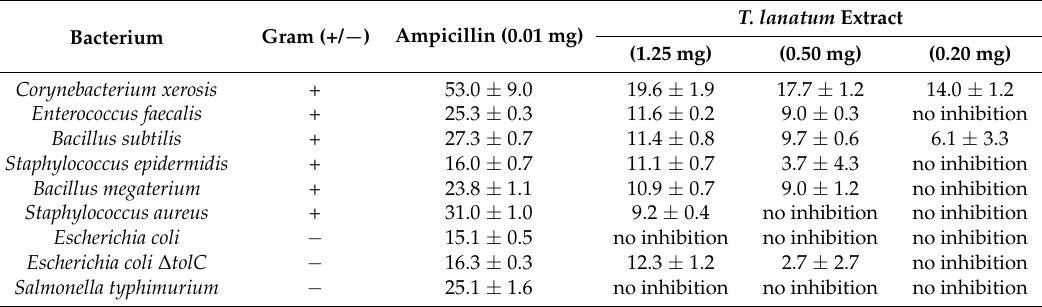
Figure 2. Immunomodulatory activity of T. lanatum extract. The amount of the pro-inflammatory cytokine TNF- α present in the supernatant of macrophage cultures was determined using ELISA at 12 and 24 h after treatments. Cells treated with DMSO (non-activated) were used as negative controls and cells treated with LPS (activated) were used to represent a pro-inflammatory response. Results from an ANOVA test suggest that activation of macrophages significantly alters [TNF- α ] at both the 12-h ( P LPS-12h = 7.40 × 10 − 8 ) and 24-h ( P LPS-24h = 6.57 × 10 − 10 ) time-points. Treatment with 0.01 mg/mL T. lanatum extract significantly altered [TNF- α ] at the 12-h ( P 0.01mg/mL extract-12h = 1.29 × 10 − 2 ) and 24-h ( P 0.01mg/mL extract-24h = 7.67 × 10 − 4 ) time-points. Error bars represent ± one standard deviation from the mean response. Table 1. Antibacterial activity of T. lanatum extract a .